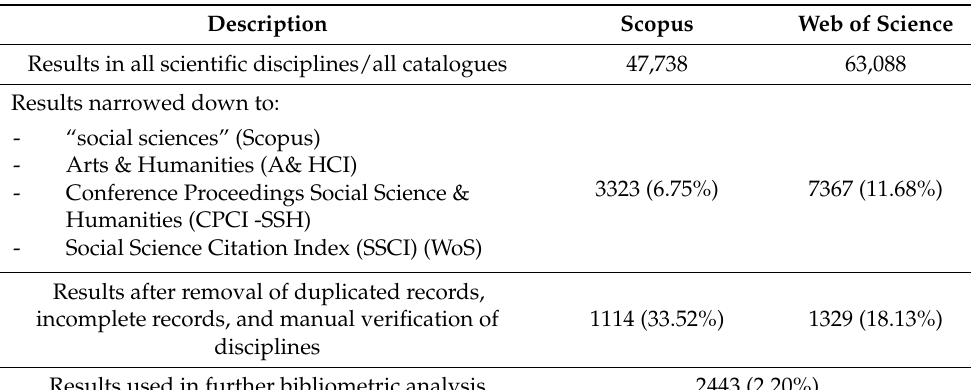
Figure 3. Phases of preparatory work for the needs of bibliometric analysis presented in the paper. Table 2. Results of the literature search